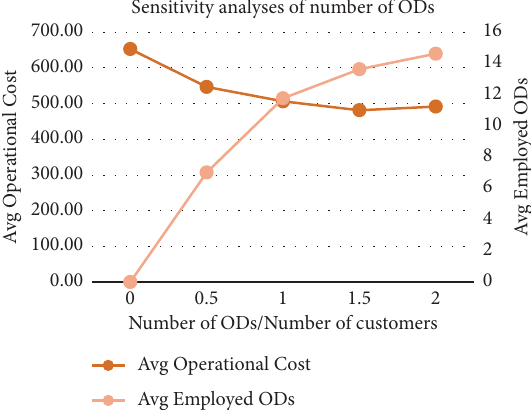
Figure 4: Sensitivity analyses of the number of ODs.